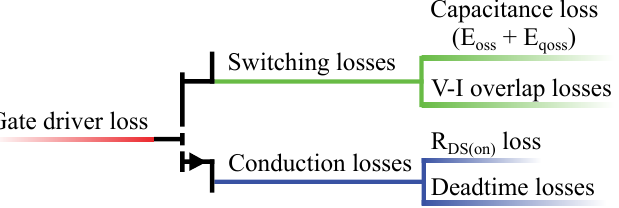
Figure 6. Major sources of losses in GaN